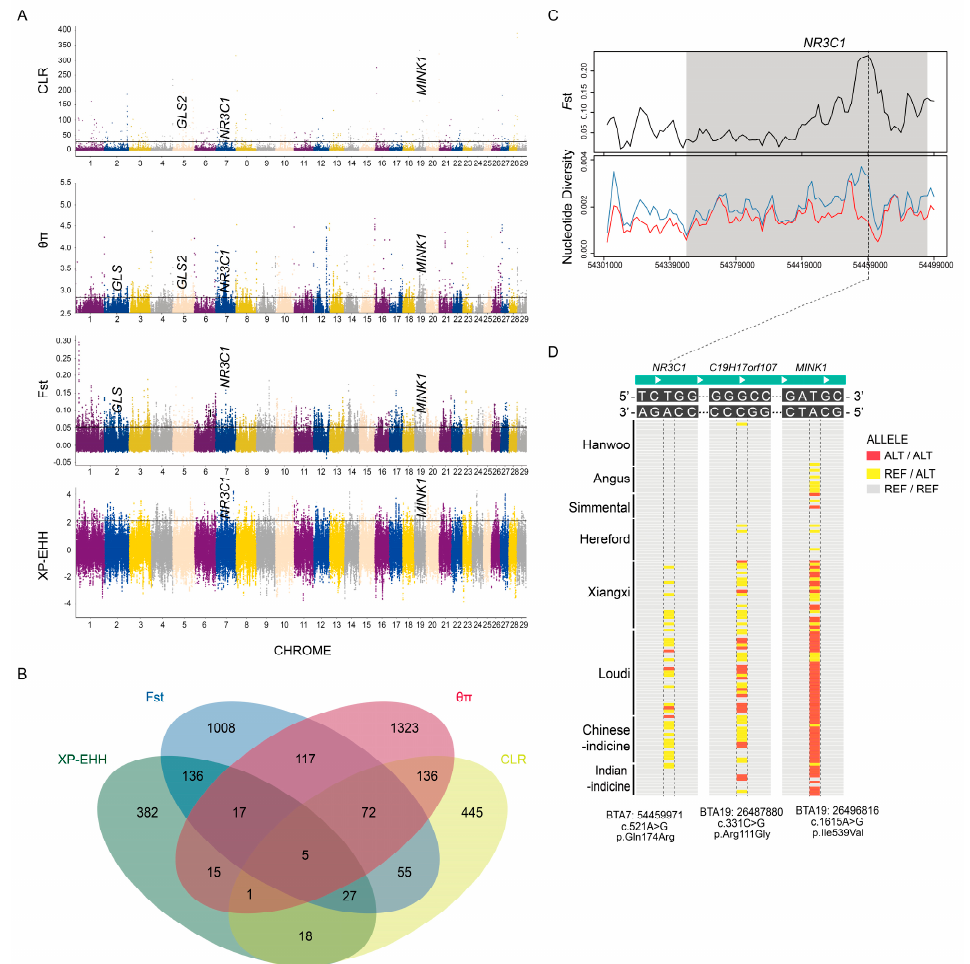
Figure 4. Selective sweep analysis of Loudi cattle. ( A ) Manhattan plot showing the four methods of CLR, θπ , F ST and XP-EHH. ( B ) Venn diagram showing the gene overlaps among θπ , CLR, F ST and XP-EHH. ( C ) F ST and nucleotide diversity plots in the NR3C1 gene region. The red line represents the reference group of Xiangxi cattle. ( D ) Regional highlight of the missense mutation of NR3C1 , C19H17orf107 and MINK1 .